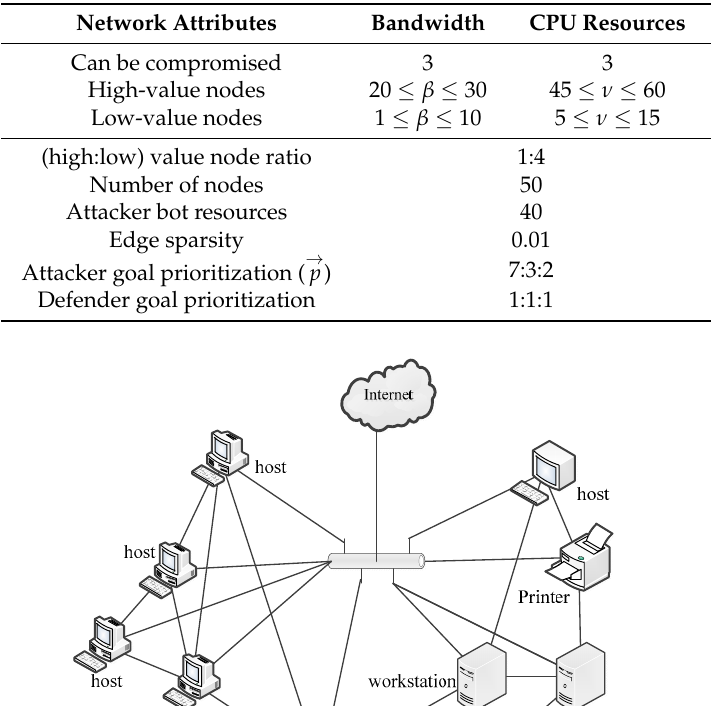
Table 1. Configuration of the game model.